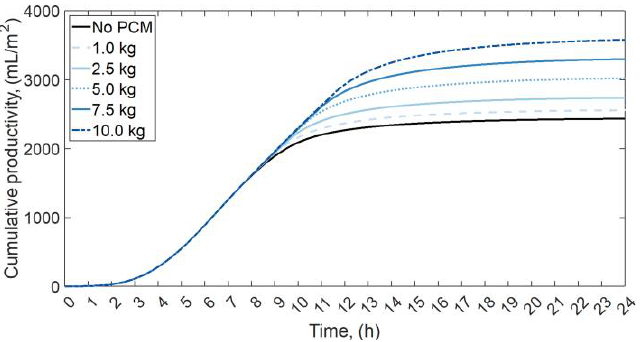
Figure 19. The cumulative productivity of the SS with different masses of PCM — Case 3.